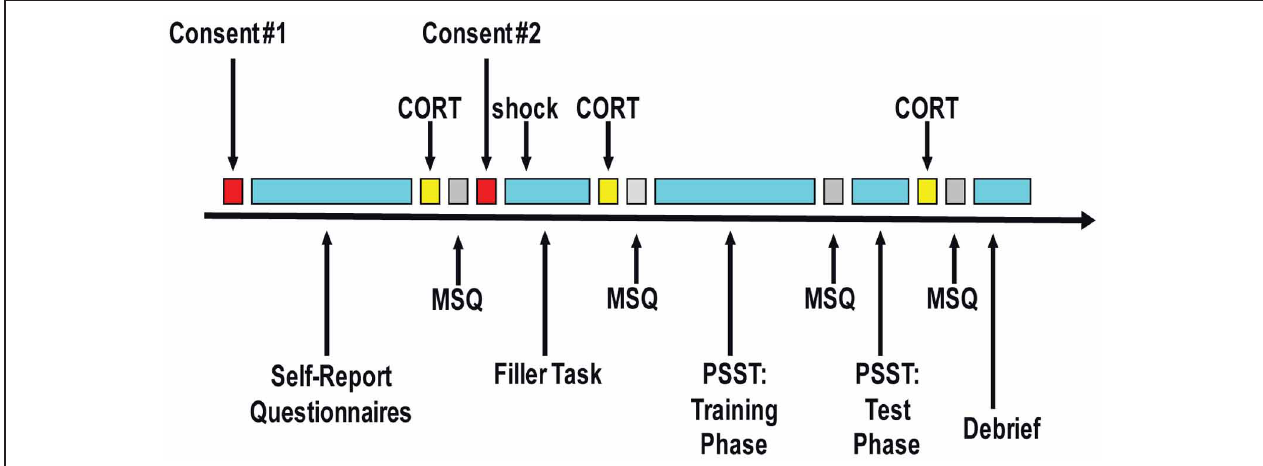
FIGURE 1 | Schematic representation of the session timeline. CORT, collection of saliva sample to measure cortisol level; MSQ, mood state questionnaires (“in-the-moment” state self-report questionnaires); PSST, Probabilistic Stimulus Selection